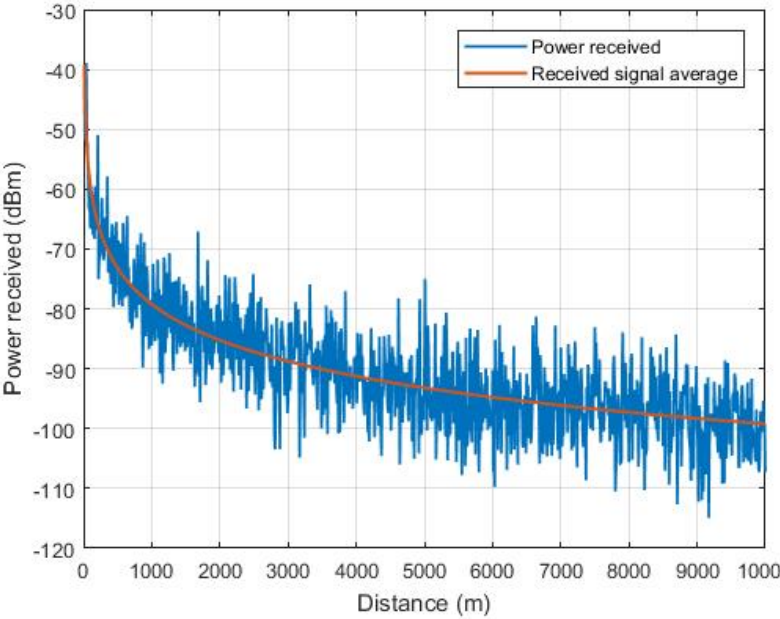
Figure 17. Simulated behavior of the power received by the XBee transceiver.